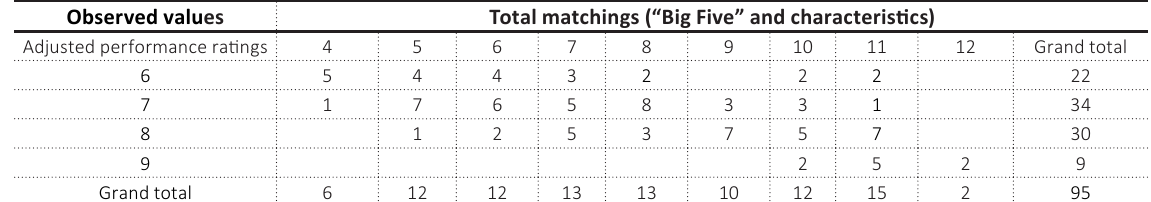
Table 4. “Observed frequencies” of matching vis-à-vis performance ratings Observed values